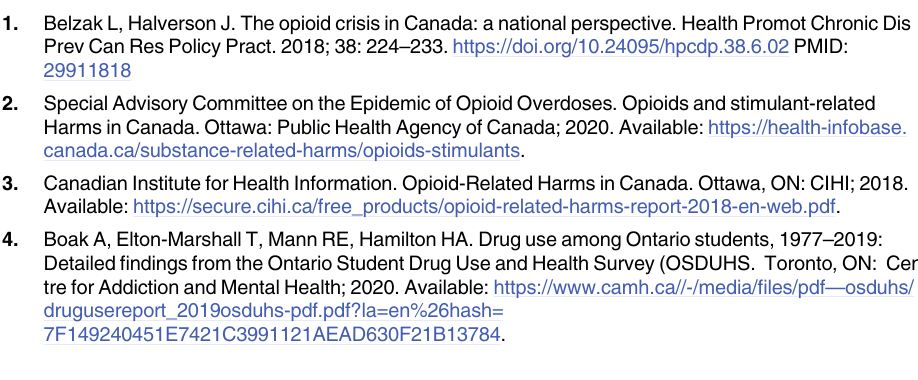
S1 Table. Comparative analysis of opioid-using respondents by receipt of opioid storage and disposal